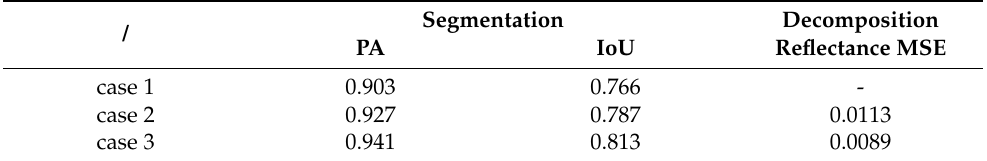
Table 1. Parameter sharing in joint learning.